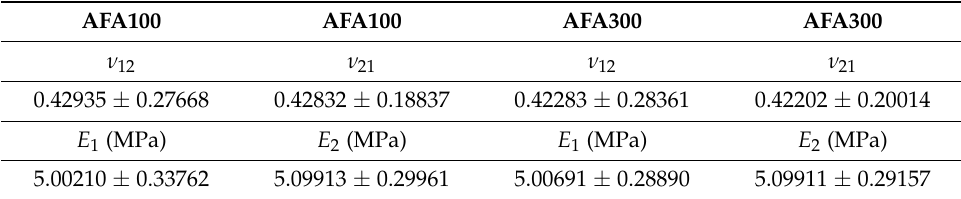
Table 3. Mean value ( ± SD) of mechanical parameters with biaxial tests on AFA films.